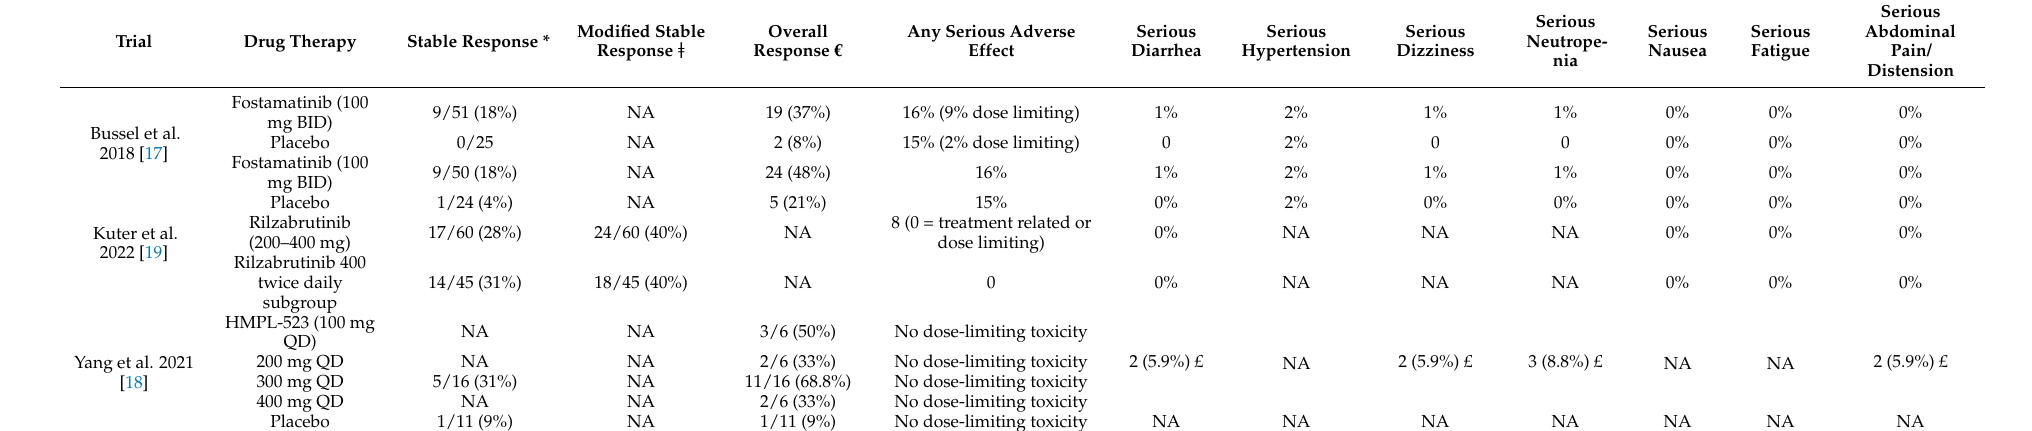
Table 2. Efficacy and safety data of tyrosine kinase inhibitors in immune thrombocytopenia.